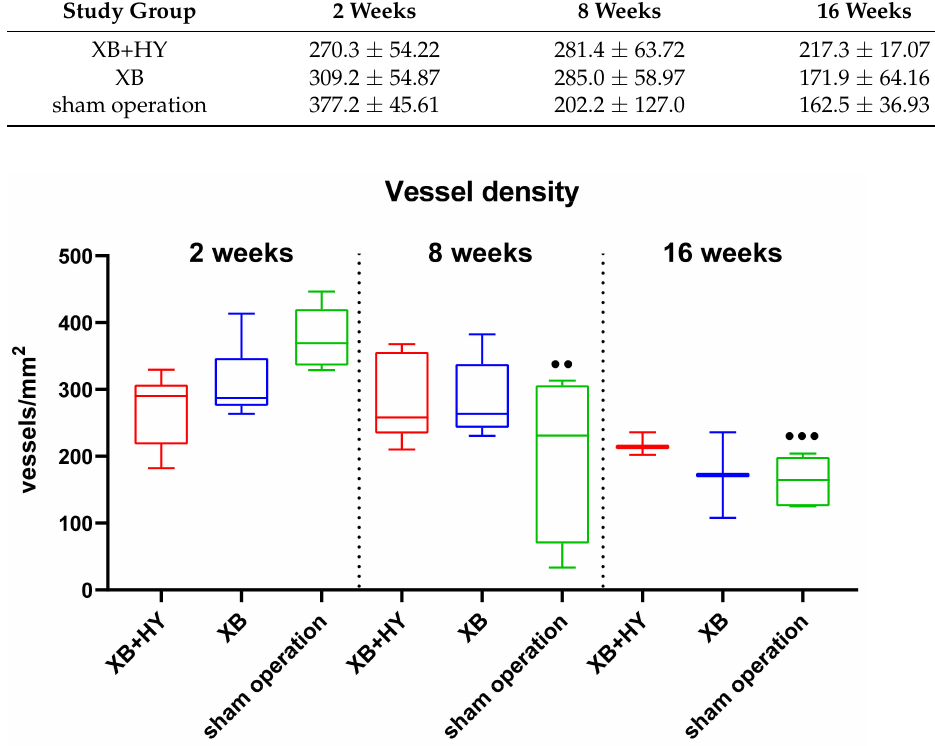
Figure 8. Results of the histomorphometrical analysis of the vessel densities within the im-